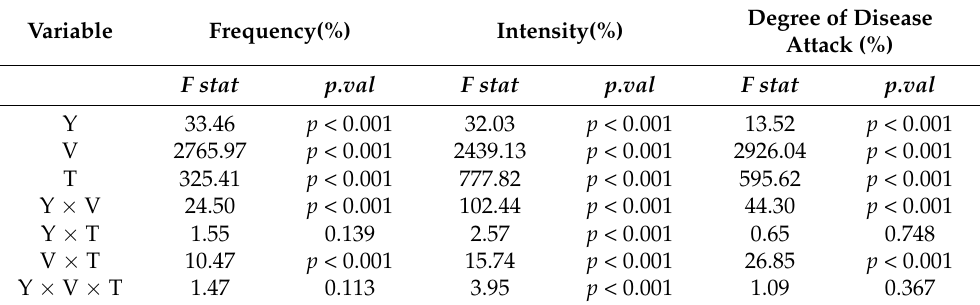
Table 2. Two-year (2018–2019) ANOVA analysis of the interactions between different variables and the fungal pathogen presence ( p < 0.001) in blackberry varieties.